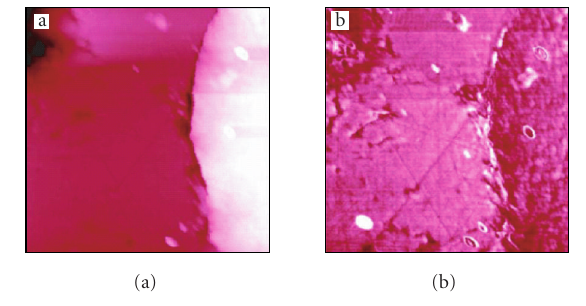
Figure 13: Simultaneous AFM (a) (20 μ m, Z range 2 μ m) and SNOM (b) of a part of a petrified bacterium (dark contrast, right part) in a polished dolomite sample with some pyrite geodes under the surface and dust particles on the surface.